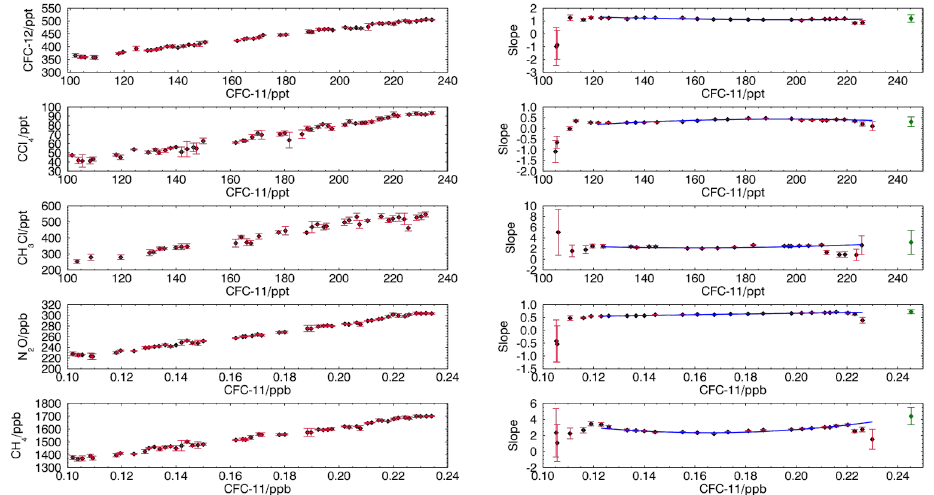
Figure B16 Correlations between the volume mixing ratios of CFC-12, CCl 4 , CH 4 , CH 3 Cl and N 2 O and CFC-11 for the data from the southern hemisphere during the stratospheric winter of 2005. Left panels: The mean correlation profile. Each point represents the mean of the VMR in a window of 2 ppt of CFC- 11. The error on these points is the standard deviation of the data within each 2 ppt window. Right panels: The local slope of data in an 80 ppt of CFC-11 window. The error on the points is the fitting error of this fit. The blue line is a second degree polynomial fit to the local slopes. The green point is the extrapolated slope at the tropopause.